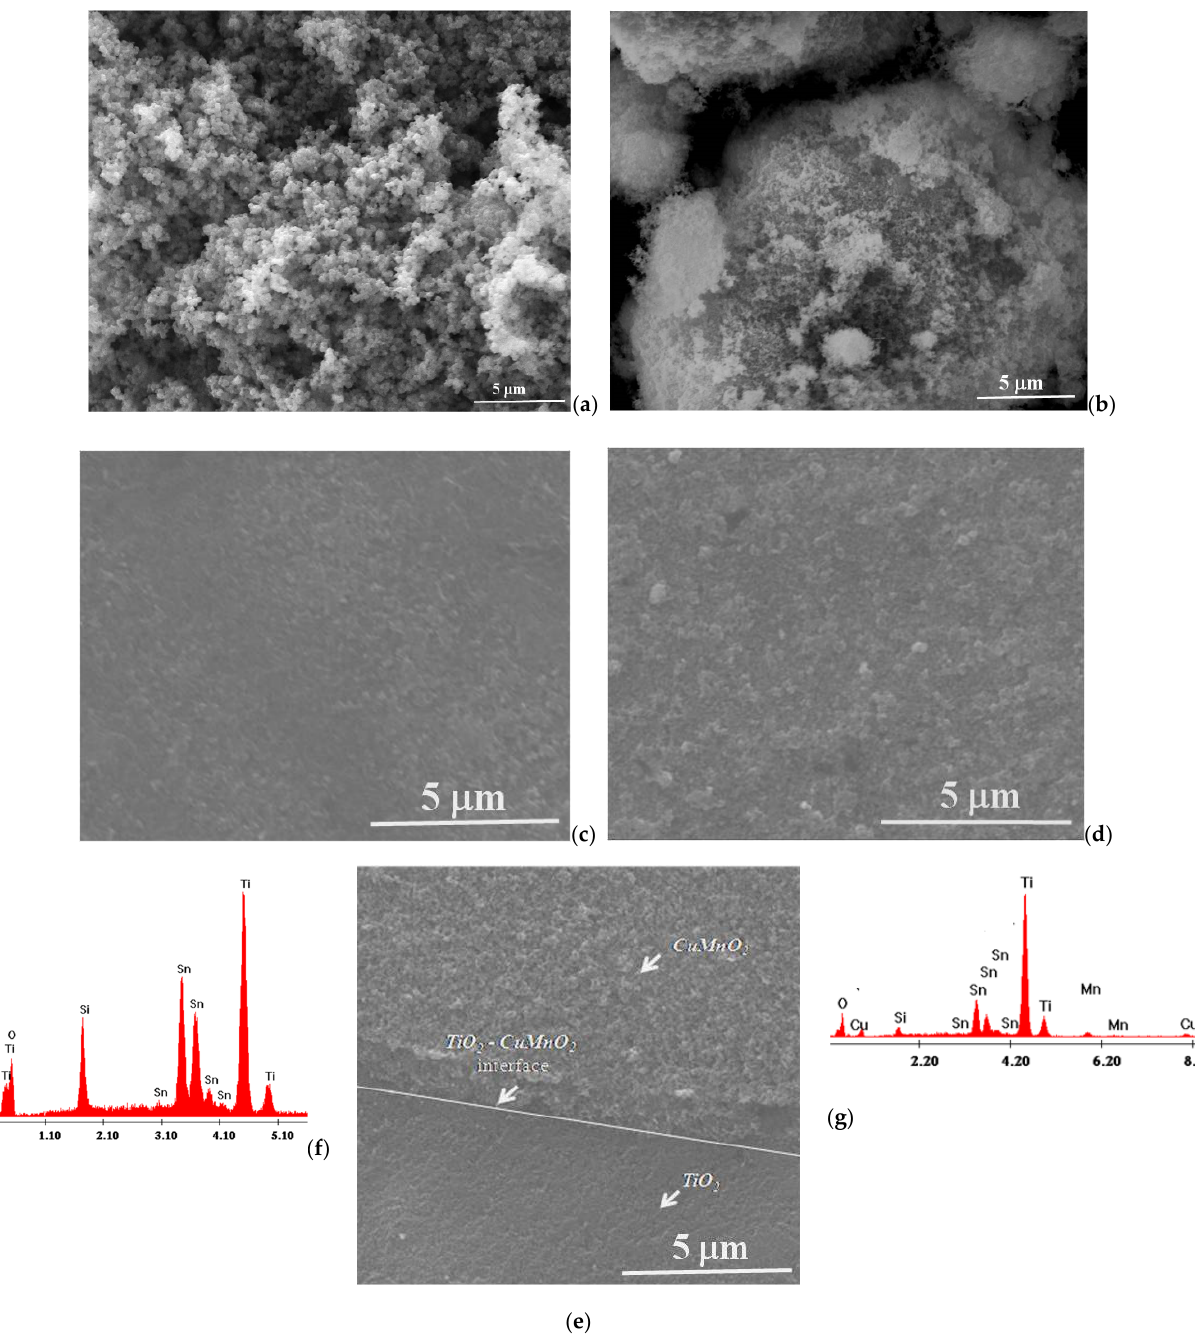
Figure 3. SEM images of the TiO 2 ( a ) and CuMnO 2 powders ( b ); TiO 2 ( c ) and CuMnO 2 films ( d ); interface TiO 2 -CuMnO 2 films ( e ); EDX spectra of the FTO-TiO 2 ( f ) and FTO-TiO 2 -CuMnO 2 ( g ) structures.